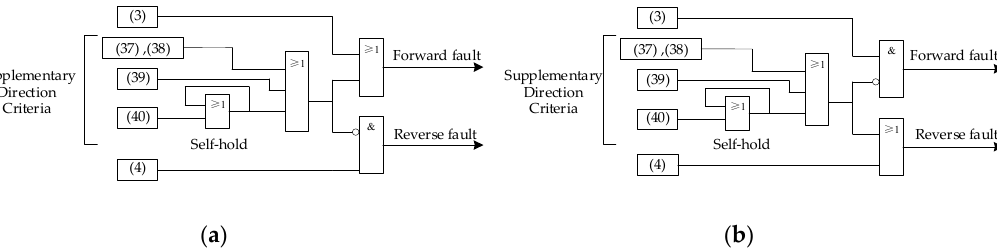
Figure 12. Operation logics of the mitigation countermeasures: ( a ) wind farm side; and ( b ) grid side.